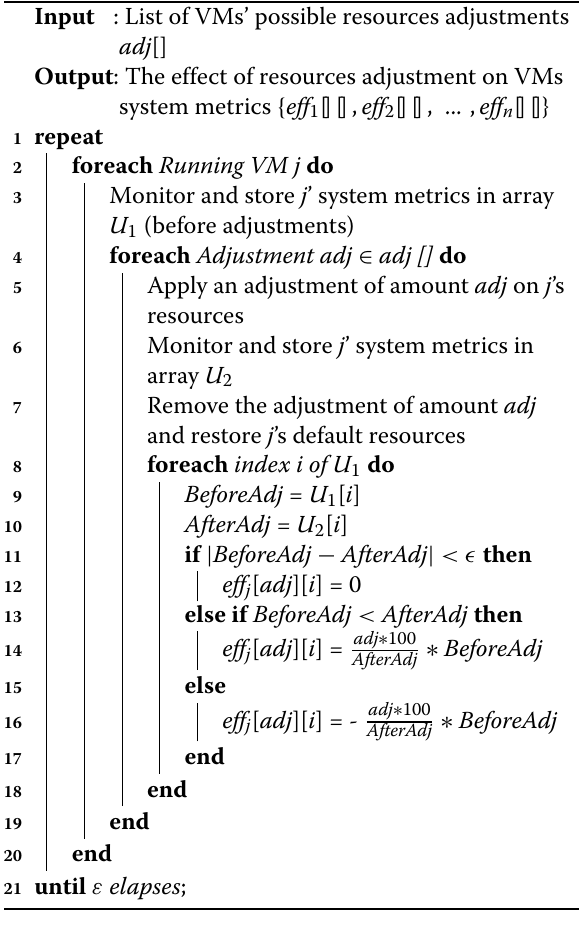
Algorithm 1: Determining the effect resources adjustments on VMs system